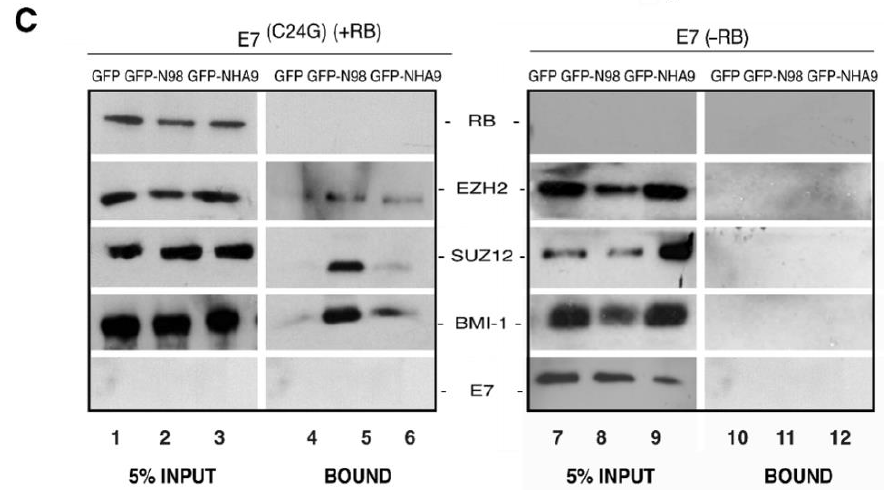
Figure 4. Association of RB with PcG proteins in NUP98–HOXA9 expressing cells. Respective proximity ligation assays (PLA) between RB and PcG proteins EZH2, SUZ12, BMI-1, and RING1A in HCT-116 cells expressing GFP-NHA9 (green) or GFP-N98 (green). Representative immunofluores- cence images are shown in ( A ) DAPI (blue) staining was used to visualize the nuclei. Scale bars, 5 µ m. ( B ) PLA foci per cell (magenta) were quantified using Fiji/ImageJ. About 400 cells were analyzed for each sample; the number of experiments was: n = 3. * p <0.05, ns, p not significant, t -test, two-tailed. ( C ) GFP-trap assays to study the potential interaction of NHA9 with PcG proteins EZH2, SUZ12, and BMI-1. GFP-NHA9 were transiently expressed in HCT-116 cells; GFP and GFP-N98 expression was employed as control. After 48 h, GFP proteins and associated factors were recovered from cell lysates and probed by Western blot analysis using antibodies against EZH2, SUZ12, and BMI-1. The proteins had the following expected molecular weight: RB:110 kDa; EZH2: 98 kDa; SUZ12: 83 kDa; BMI1: 41 kDa; E7: 20 kDa. The number of experiments was: n = 3.